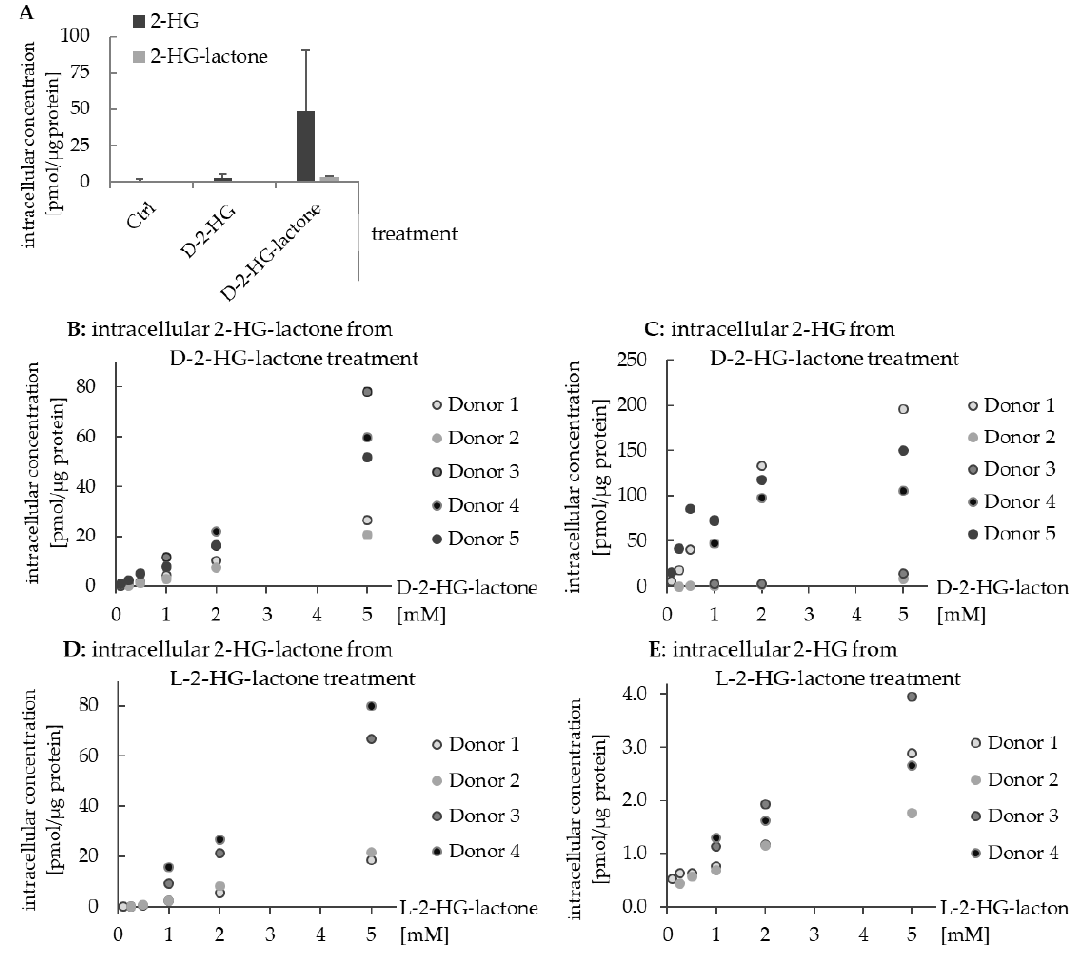
Figure 9. Difference in the uptake and hydrolysis of 2-HG and 2-HG-lactone by human macrophages. ( A ) Intracellular levels of 2-HG and 2-HG-lactone in macrophages of three donors after treatment with either 1 mM D-2-HG or 1 mM D-2-HG-lactone in comparison to untreated cells (error bars represent SD and are rather large because of donor variability). ( B , D ) intracellular 2-HG-lactone concentration after the treatment of macrophages with increasing concentrations of D-2- HG-lactone and L-2-HG-lactone, respectively. ( C , E ) Intracellular 2-HG concentration after the treatment of macrophages with increasing concentrations of D-2-HG-lactone and L-2-HG-lactone, respectively. In donors 2 and 3, the hydrolysis of D-2-HG-lactone was obviously less efficient than in the other donors, but was still on a higher level than for L-2-HG- lactone.